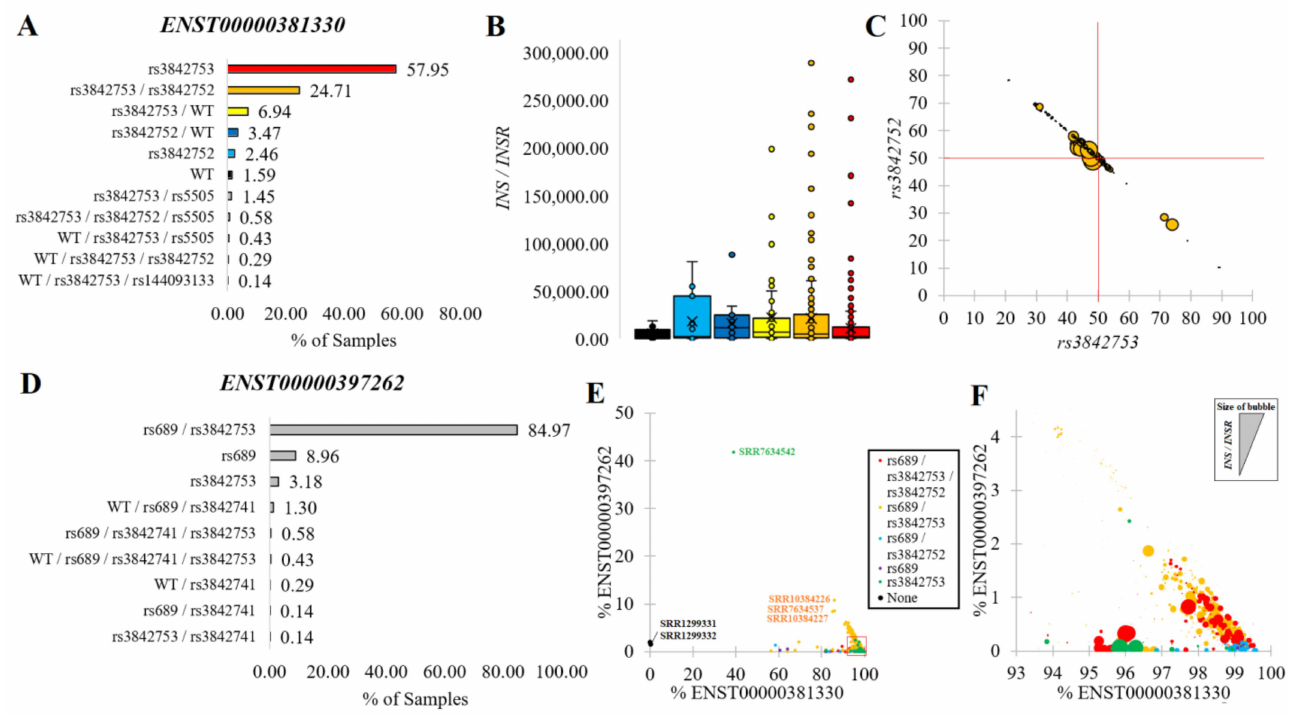
Figure 5. INS variants within transcripts. ( A ) The percentage of samples with transcripts annotated with unique and combinations of variants within ENST00000381330. ( B ) Box and whisker plots for INS / INSR normalized levels for groups as colored in Panel A. ( C ) The percent of ENST00000381330 reads containing rs3842753 (x-axis) relative to rs3842752 (y-axis) for compound heterozygous samples of rs3842753/rs3842752. The size of the bubble represents the INS / INSR normalized value. The red lines are at the 50% level. ( D ) The percentage of samples with transcripts annotated combination of variants for ENST00000397262. ( E ) Combination of Panels ( A ) and ( D ) for labeling each sample’s final genotype (colors) relative to the % of total transcripts coming from ENST00000381330 (x-axis) and relative to ENST00000397262 (y-axis). ( F ) Zoomed-in view of the Panel E red box with the bubble size representing the INS / INSR normalized